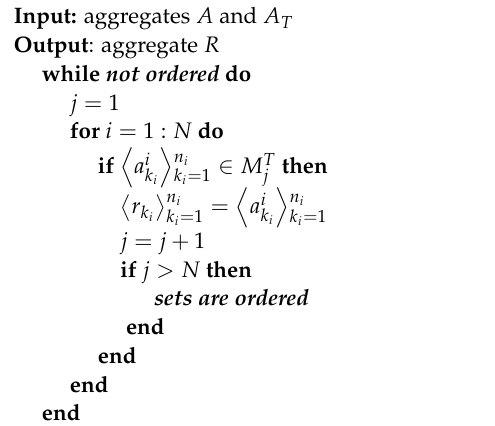
Figure 16. An example of applying the sets ordering operation.